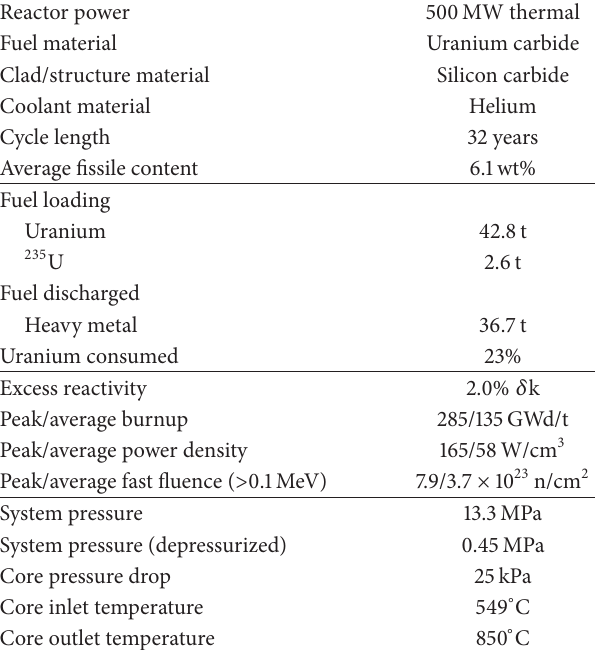
Table 1: Summary of EM 2 baseline core performance.